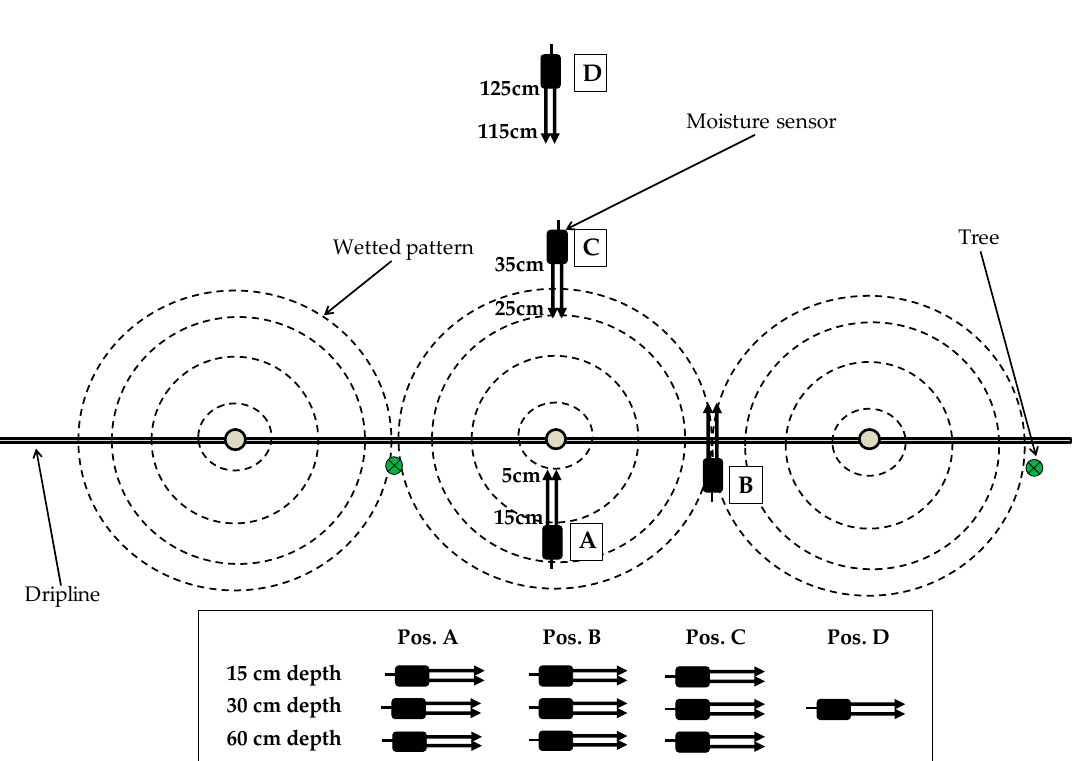
Figure 1. EC-5 and 10HS moisture sensors installed at three depths (15, 30 and 60 cm) in four positions relative to the dripper (Pos. A: center of wet bulb, Pos. B: mid-point between two drippers, Pos. C: perimeter of the wet area, Pos. D: outside the influence of the dripper. Table 2. Deployment of 10HS sensors in the study